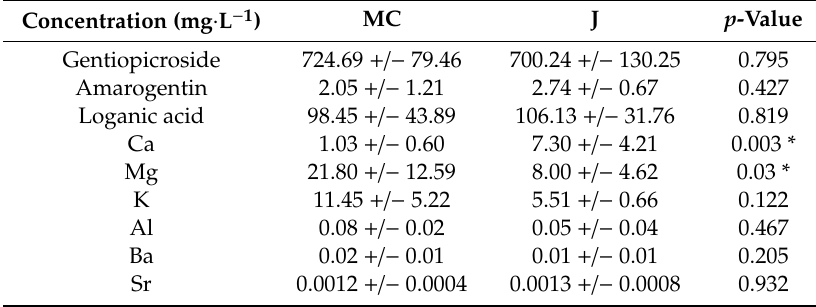
Table 1. Mean concentration (MC) of the three main bitter compounds analyzed and mineral elements statistically di ff ering from the two sampling sites present in gentian roots from the two sampling sites. extracts, expressed in mg · L − 1 , with their associated mean standard deviation and the result of p -value from the analysis of variance between the two geographic sites. When the di ff erence between sites is statistically di ff erent ( p -value < 0.05) the symbol * is indicated on the right of the p -value.